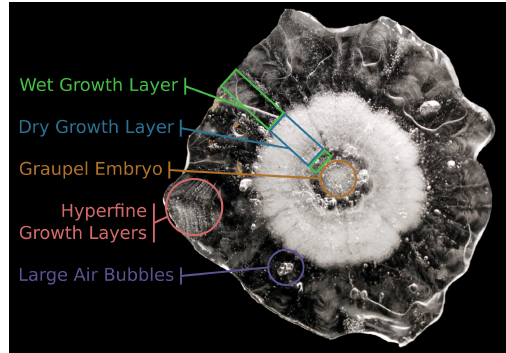
Figure 1. Schematic of common features observed within a hail- stone cross section. This hailstone is identified as number 1 in sub- sequent figures.